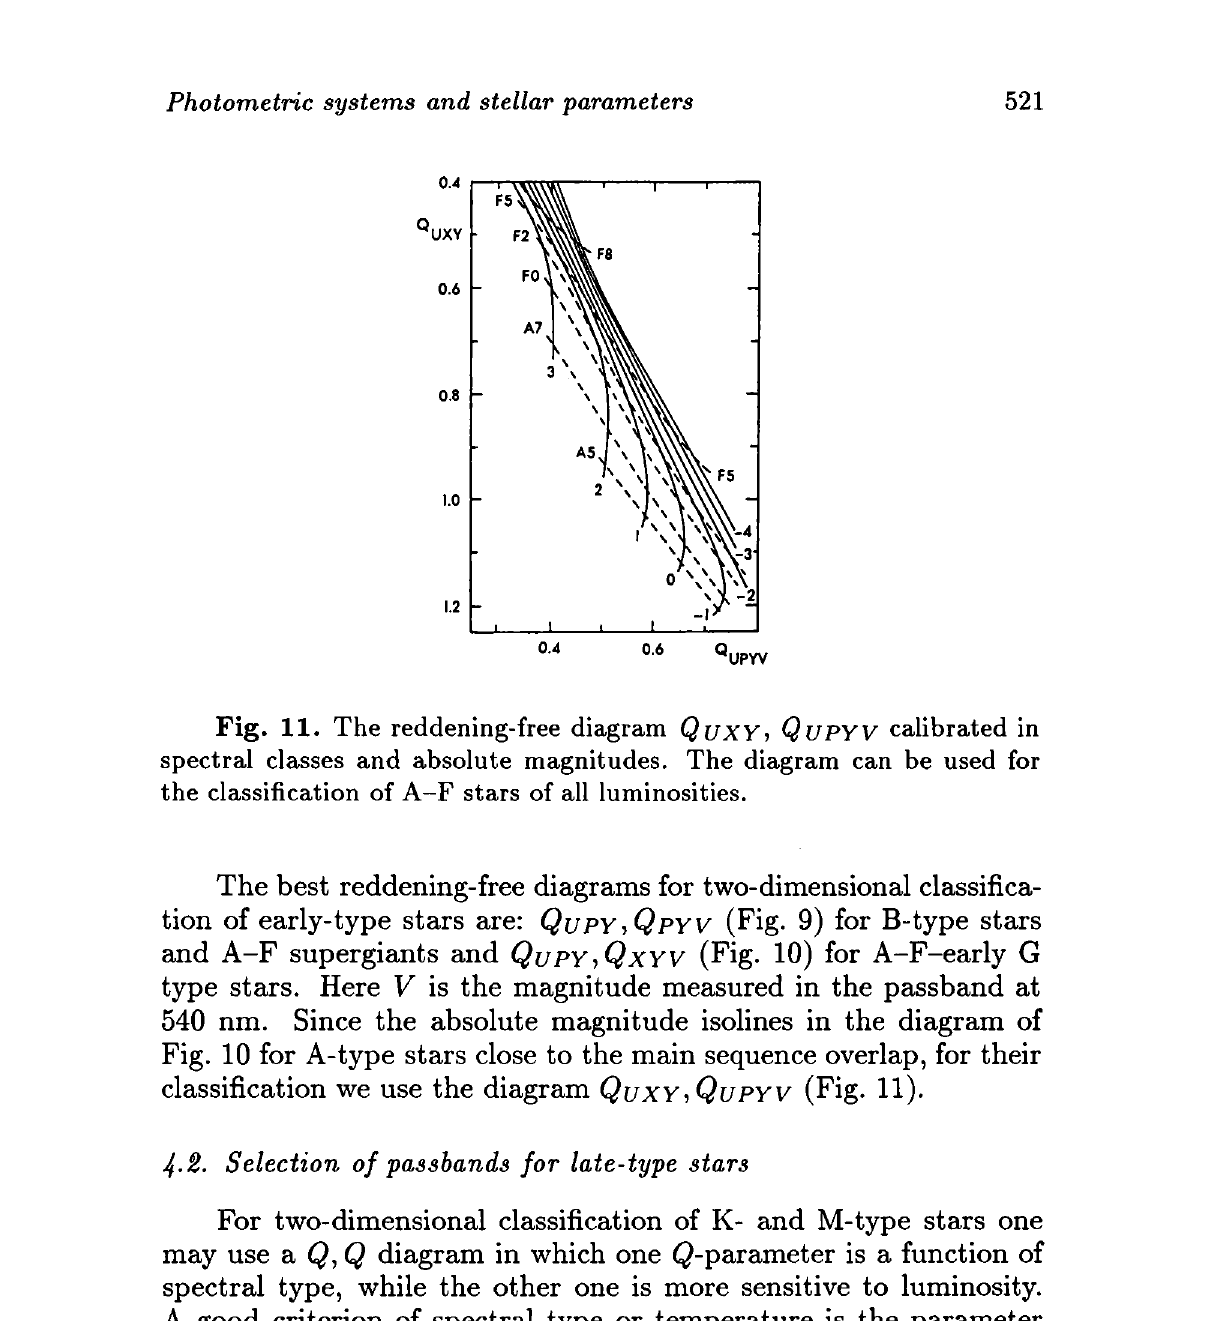
(Fig. 9) for B-type stars (Fig. 10) for A-F-early